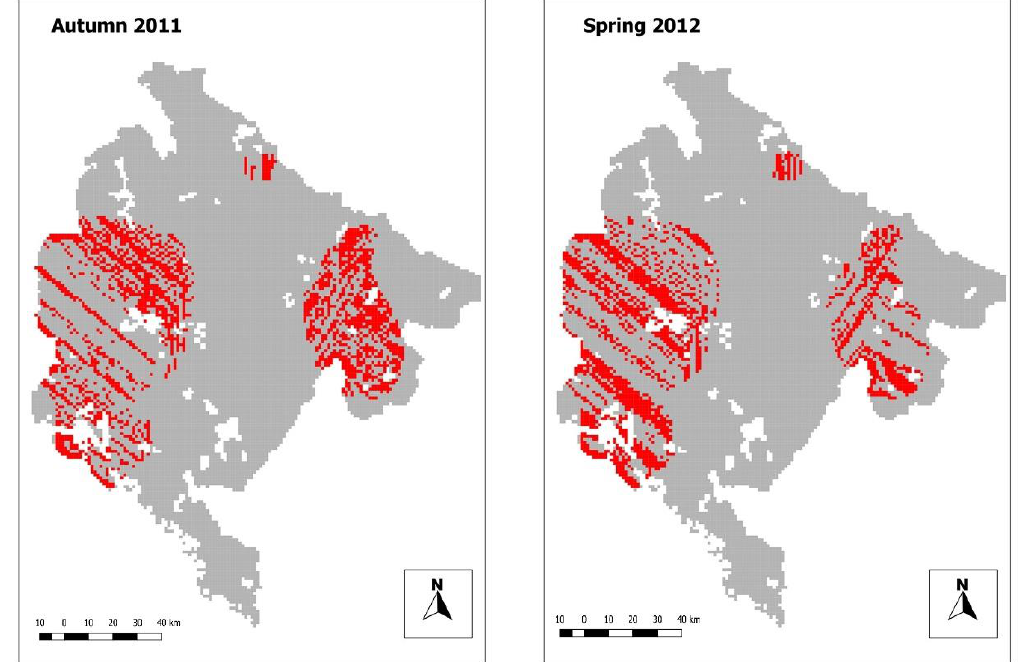
Figure 3. Critical areas: autumn 2011 campaign (on the left), spring 2012 campaign (on the right).